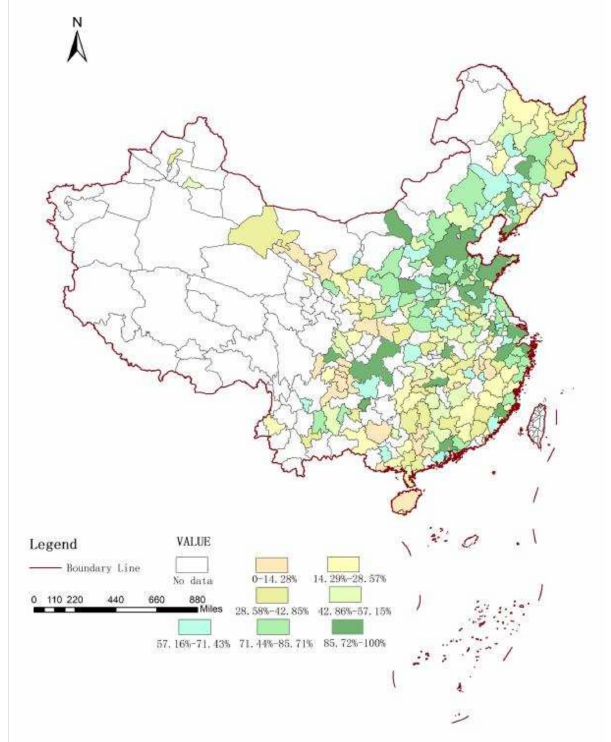
Figure 3. Carbon intensity in China,